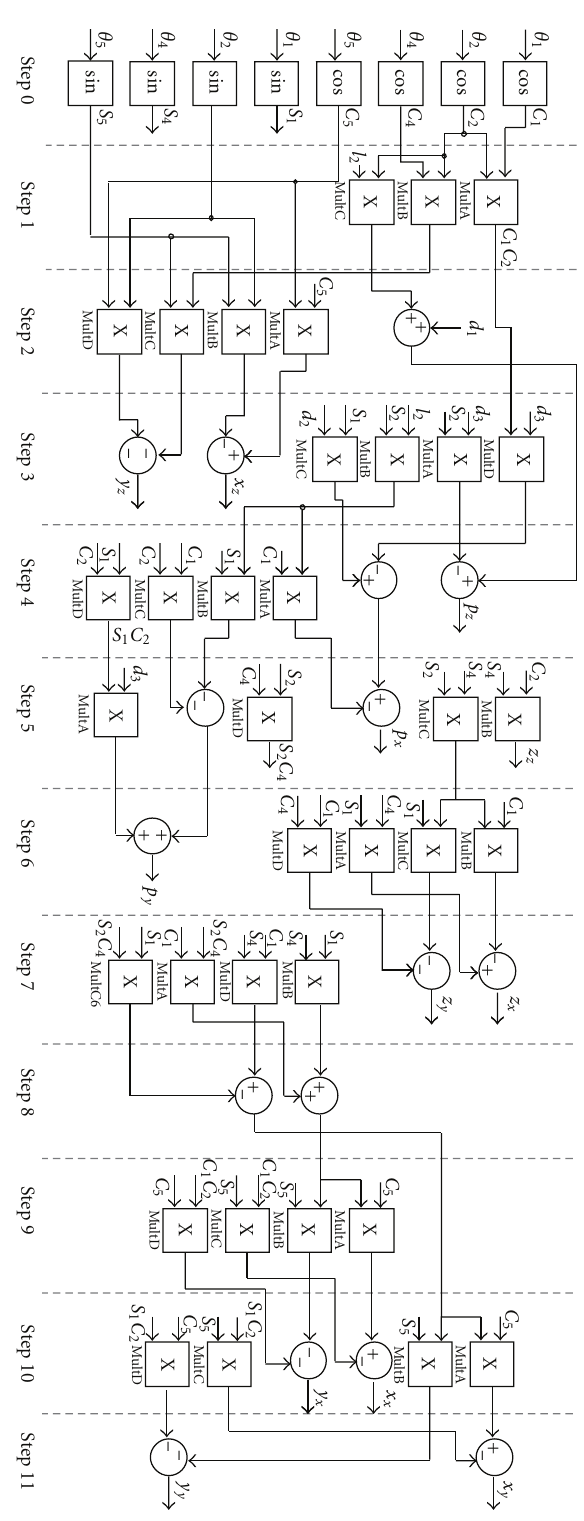
Figure 5: Hardware architecture for computing the direct kinematics using